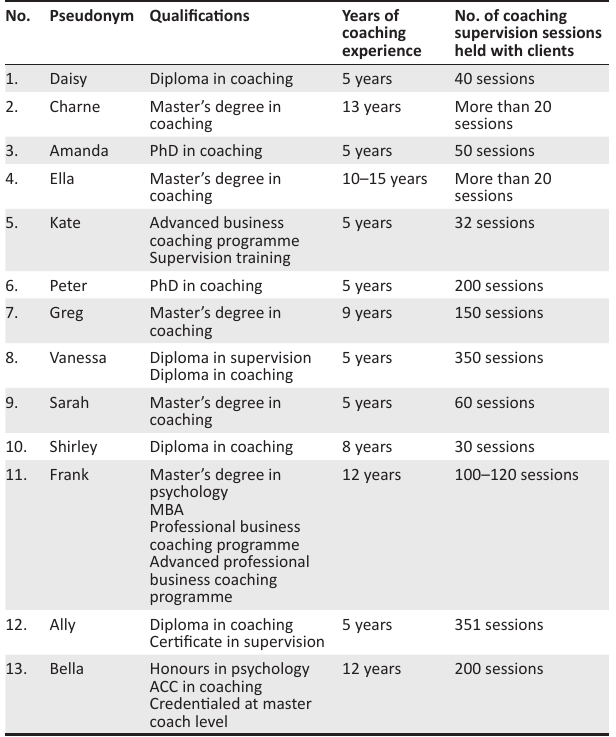
TABLE 1: Demographic representation of